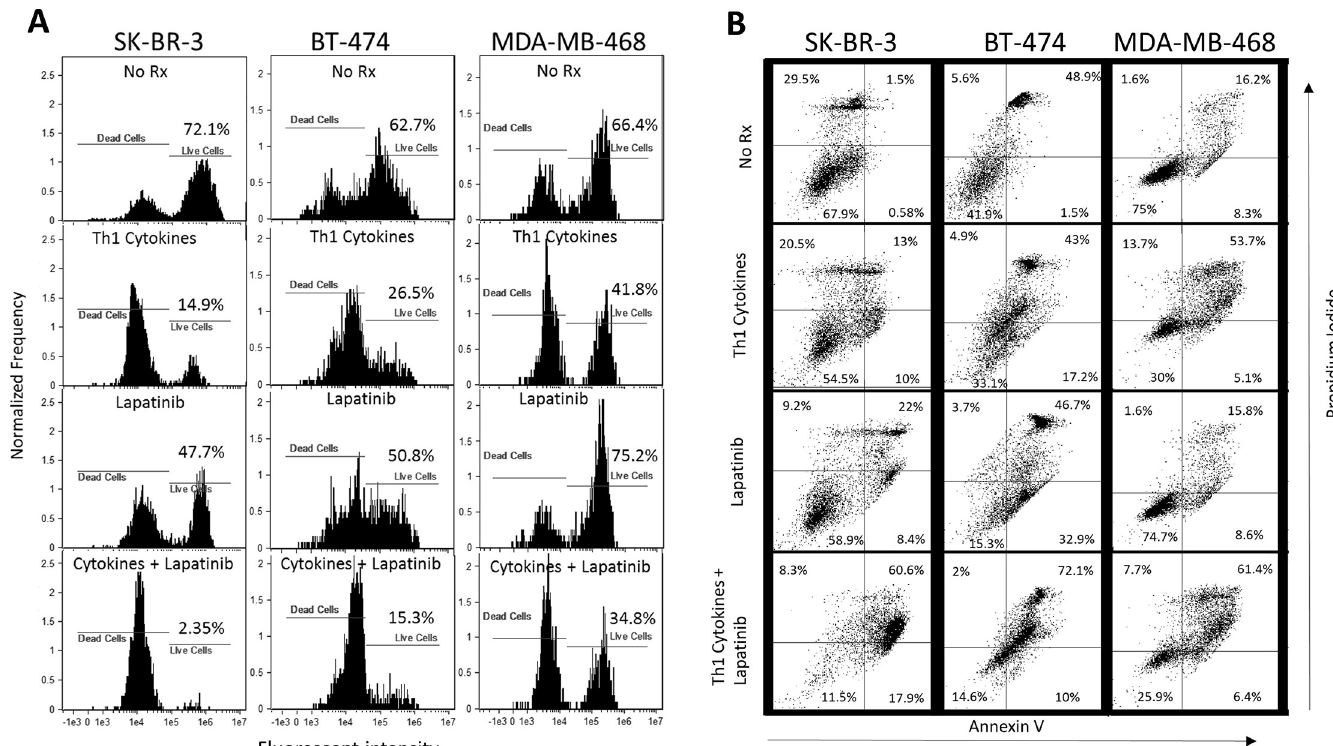
Fig 3. Lapatinib works in conjunction with Th1 cytokines to maximize indicators of apoptotic cell death. A) Cultured SK-BR-3, BT-474 and MDA-MB-468 cells were treated either with Th1 cytokines (TNF- α plus IFN- γ ; 20 and 12.5ng/ml respectively), Lapatinib (200nM), Lapatinib plus Th1 cytokines or left untreated (control). After 72 hours incubation, cells were treated with 100nMtetramethylrhodamine ethyl ester (TMRE) dye to estimate mitochondrial Δ Ѱ , as an indicator of apoptotic cell death, as assessed by flow cytometry (lower fluorescent intensity indicates disruption of mitochondrial Δ Ѱ as a consequence of apoptosis). B) Identically cultured and treated cells were harvested and stained with FITC-Annexin V and propidium iodide (PI) and subjected to FACS analysis. Two-color dot-plot analysis displays percentage of gated cells in each quadrant (double-staining cells represent late apoptotic events).